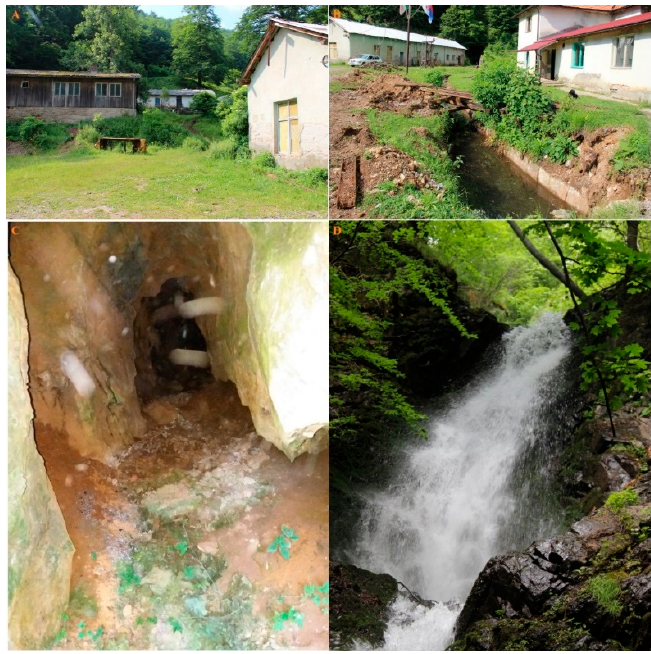
Figure 6. ( A , B ) Mining facilities in Zaplanina; ( C ) a mine shaft in Zaplanina; ( D ) waterfall